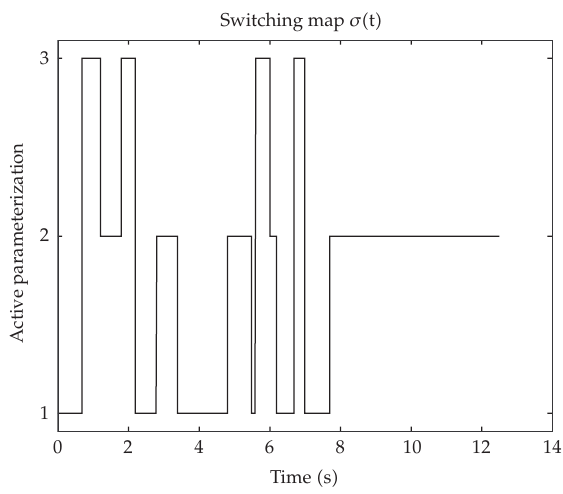
Figure 5: Switching map between di ff erent parameterizations.